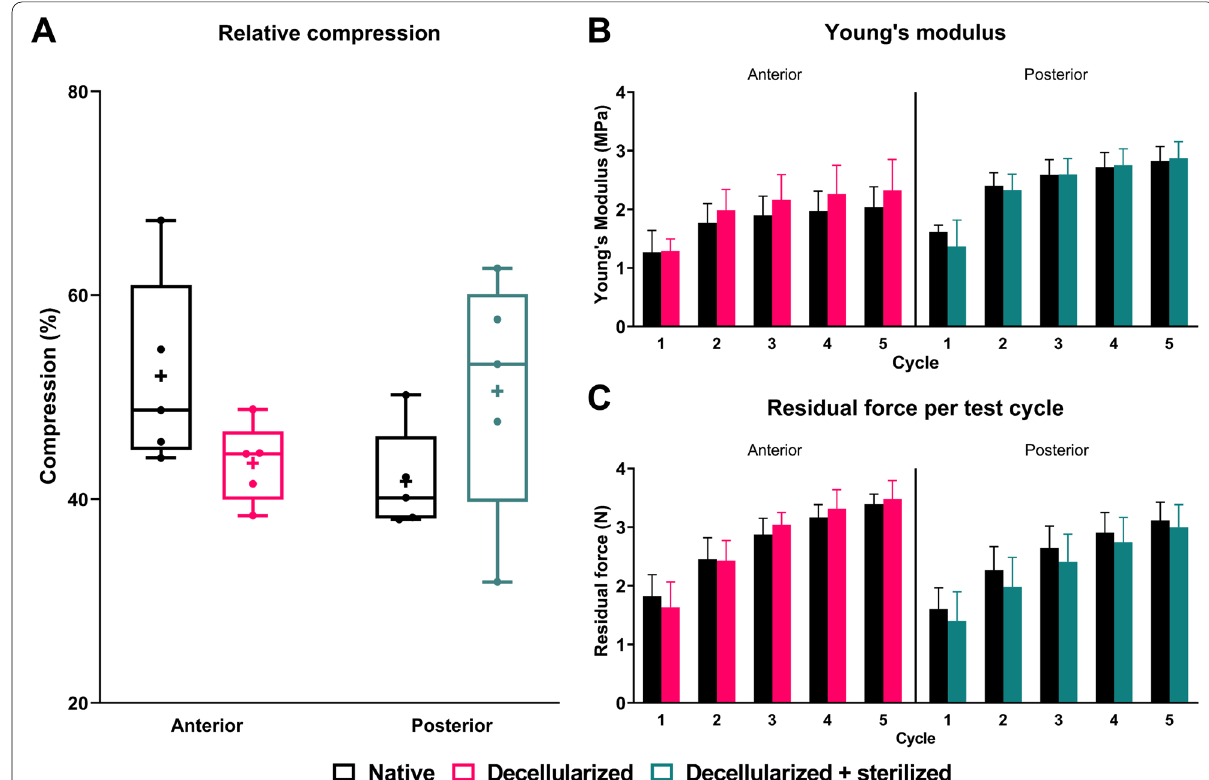
Fig. 3 Native viscoelastic behavior of human meniscus tissue is maintained after both decellularization and/or sterilization. A Percentual change in compression after test cycle 5 compared to relative sample height. B Young’s modulus per test cycle. C Residual force per test